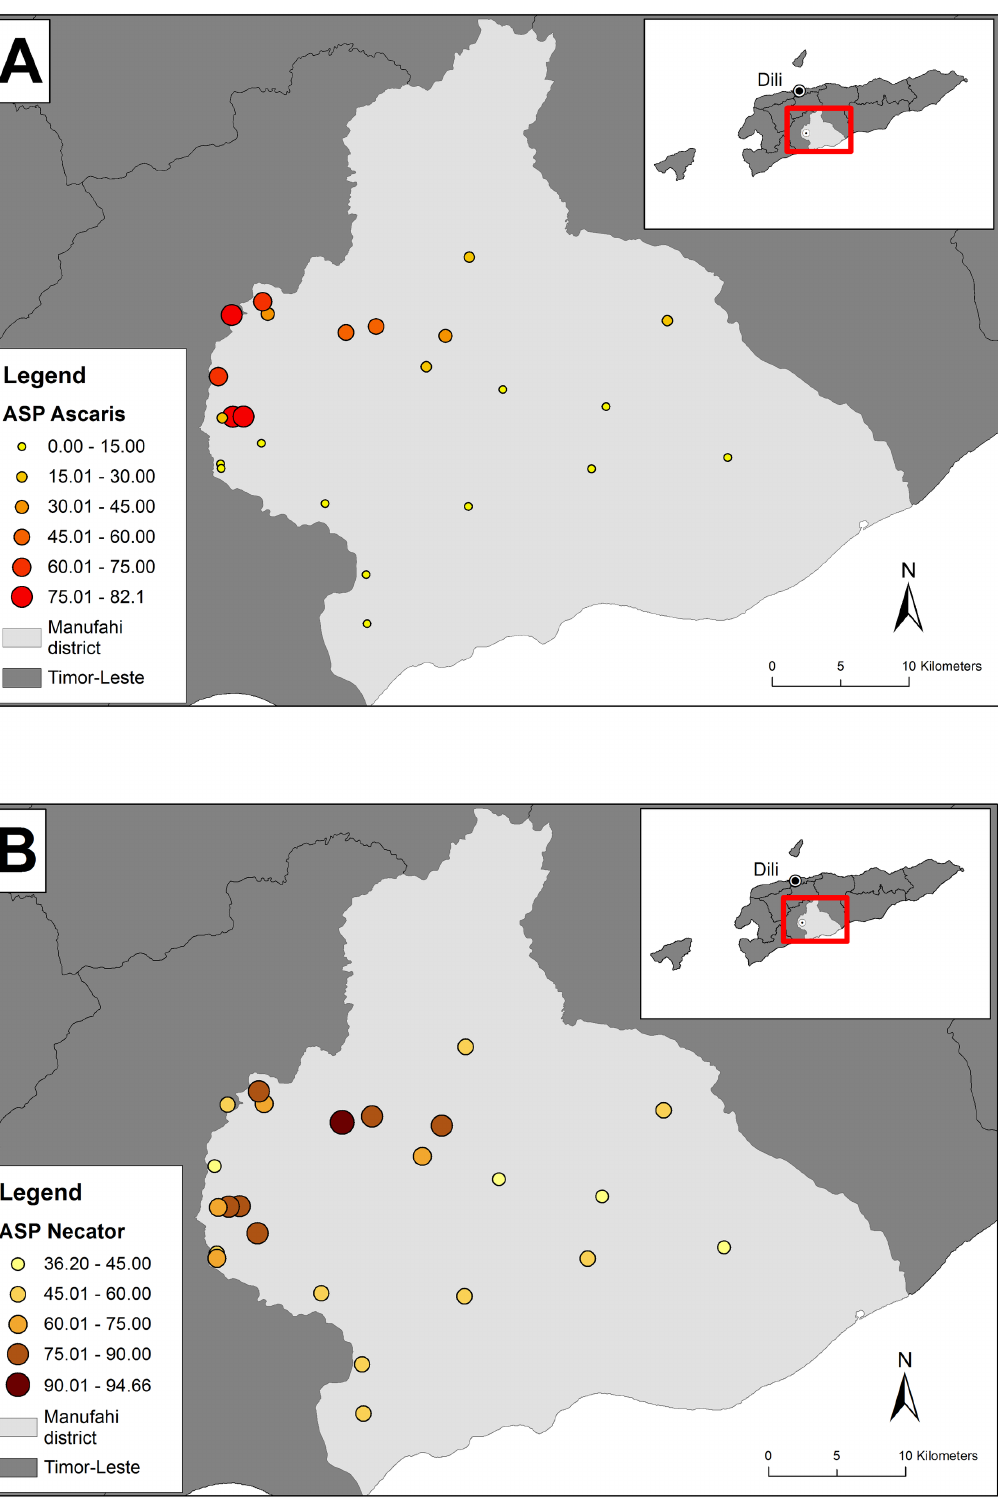
Fig 1. Baselineage standardised prevalence (ASP) of (A) A . lumbricoides and (B) N . americanus in 24 villagesin Manufahidistrict, Timor-Leste. A . lumbricoides has been shortened to Ascaris ,and N . americanus to Necator .